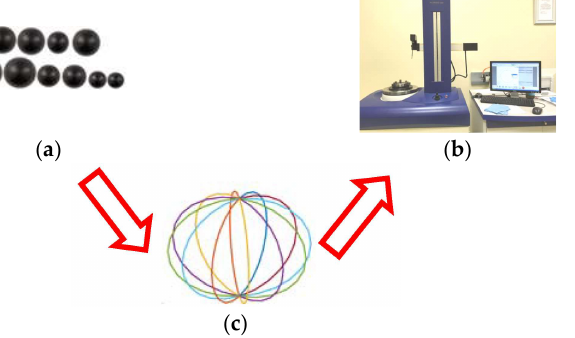
Figure 9. Sample measurement flow chart. ( a ) silicon nitride ball; ( b ) Taylor roundness instrument; ( c ) The selected section schematic diagram. Table 1. Performance parameters of silicon nitride ceramic ball.